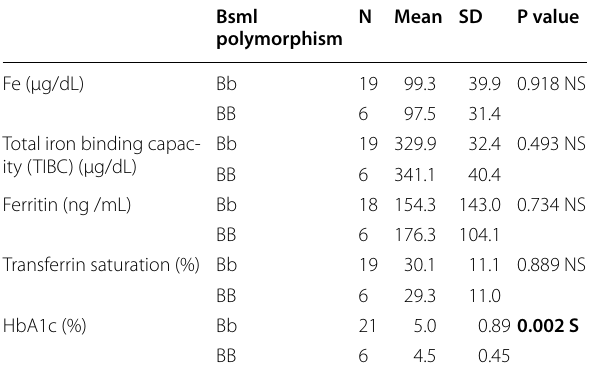
Table 5 Iron profile and HbA1C in relation to Bsml gene polymorphism among obese male medical